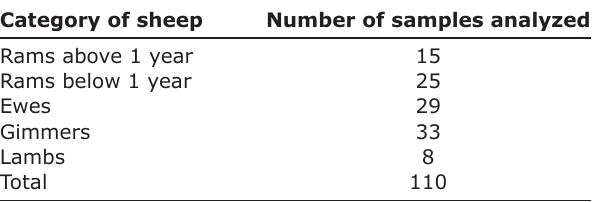
Table-1: Category of sheep and number of samples examined in Ayeduase. Category of sheep